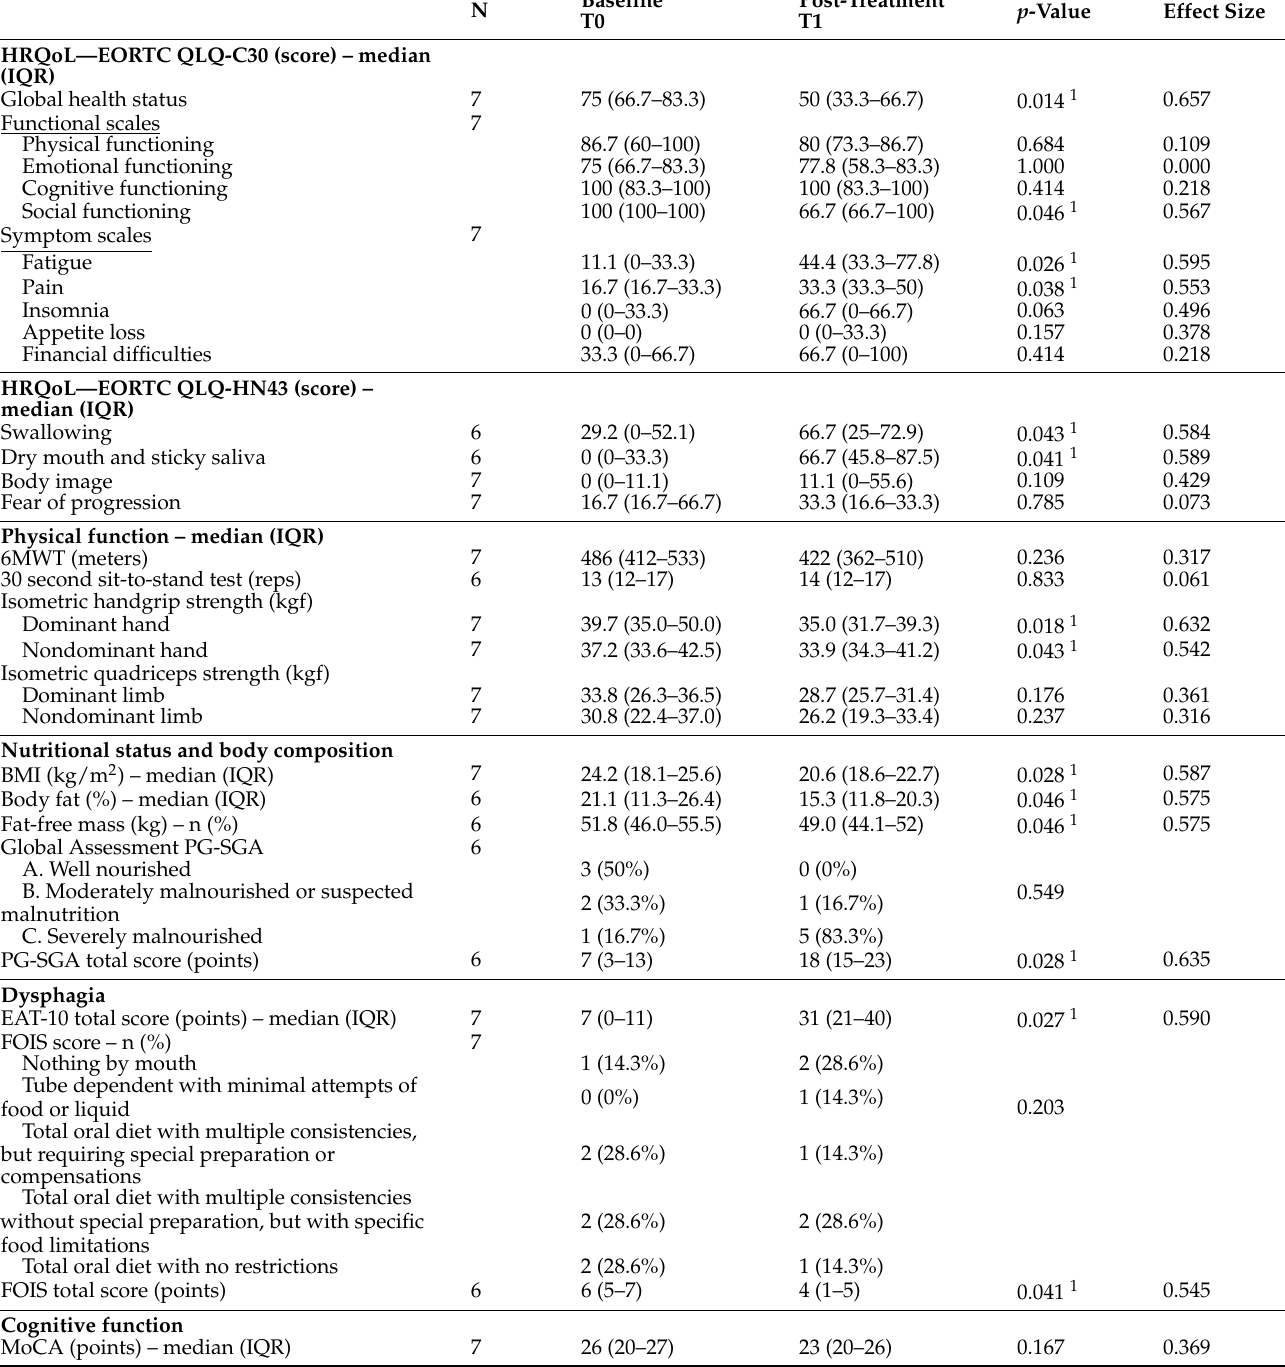
Table 3. Acute impact of CRT on quality of life, physical fitness, nutritional status, dysphagia and cognitive function (n =